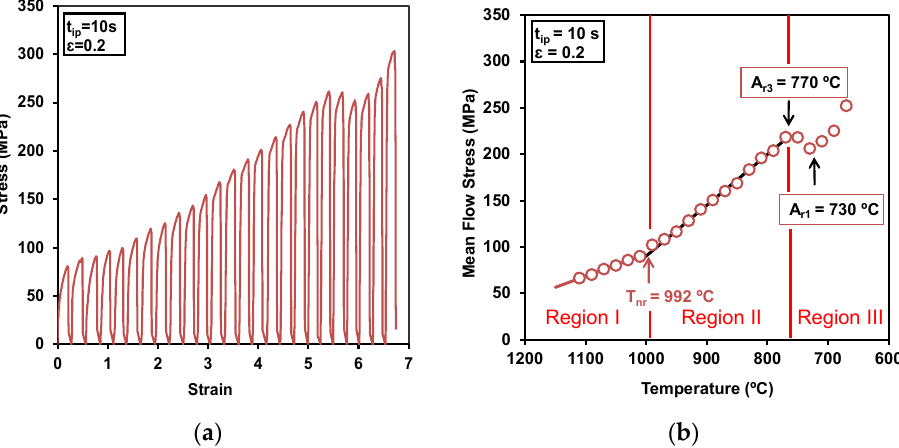
Figure 2. ( a ) Stress–strain curves obtained using the multipass torsion test (ε = 0.2, t ip = 10 s). ( b ) Mean flow stress curve versus temperature.